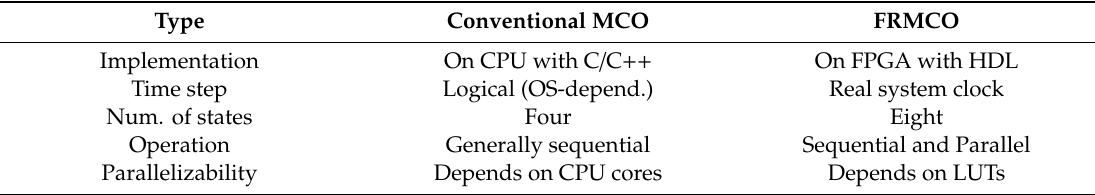
Table 2. The main di ff erences between the conventional MCO and the